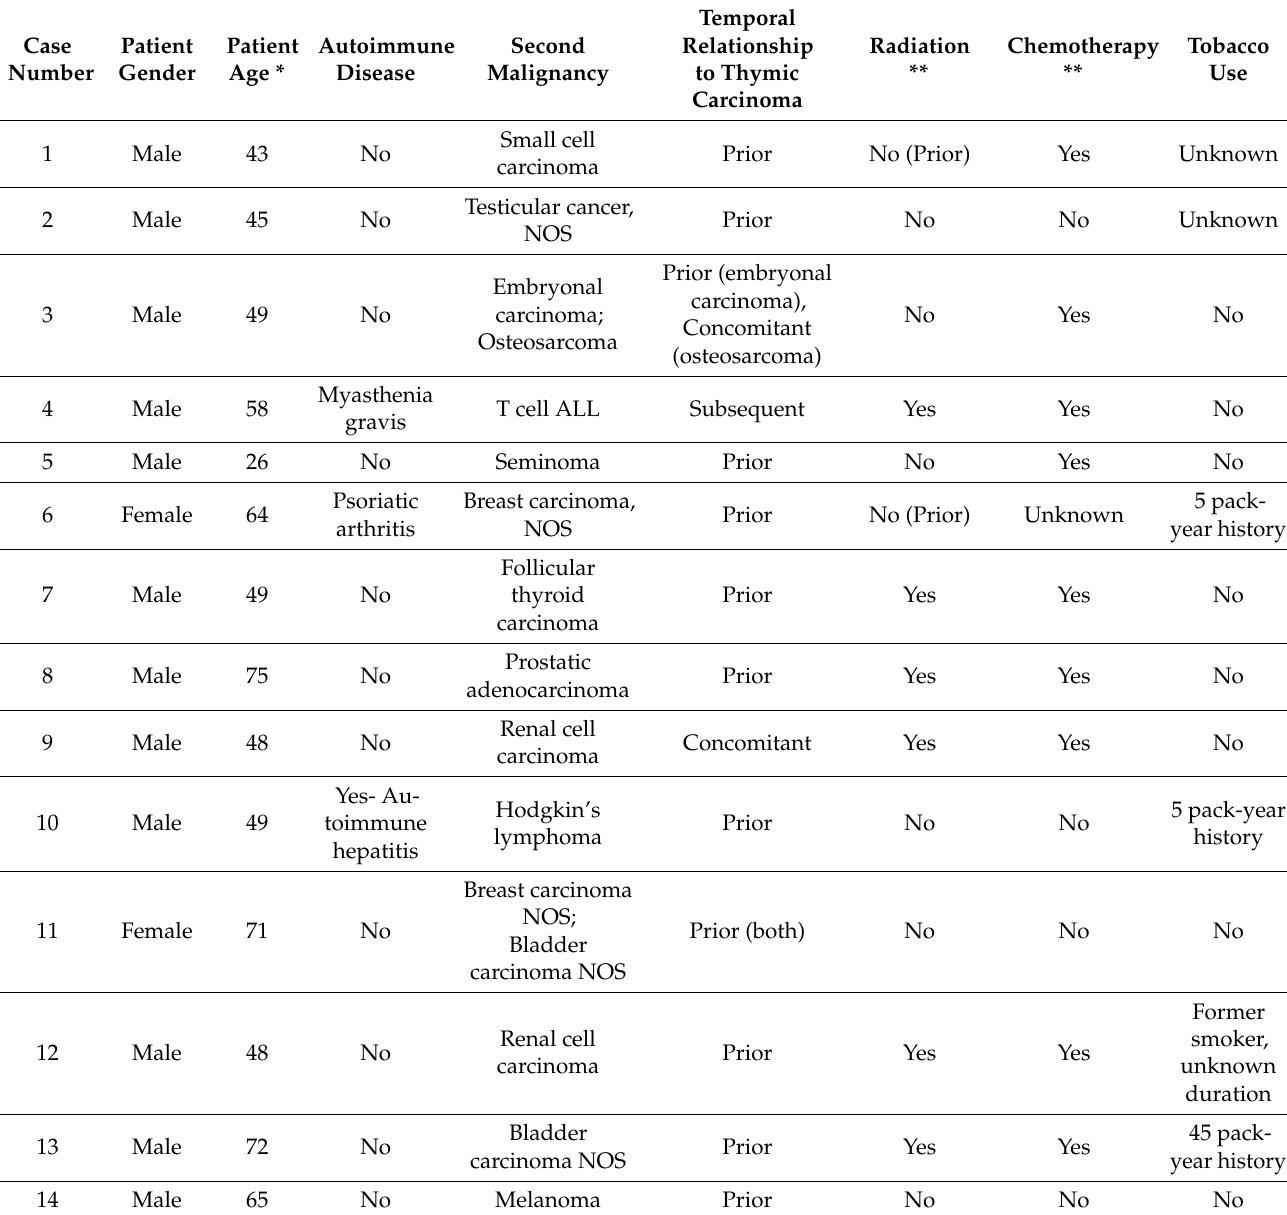
Table 2. Characteristics of the 14 patients with thymic carcinoma and second